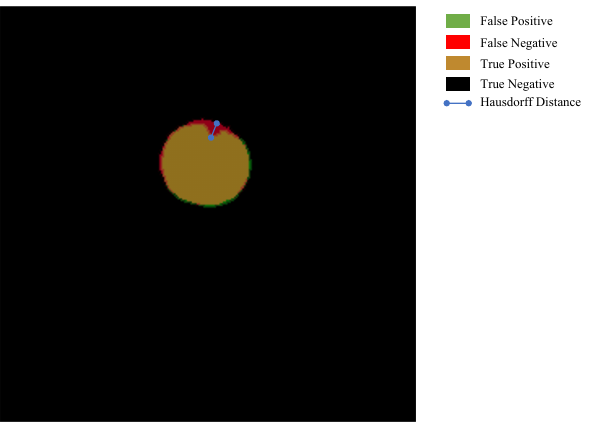
Figure 6. The visualization result of the Hausdorff distance between the GT and predicted